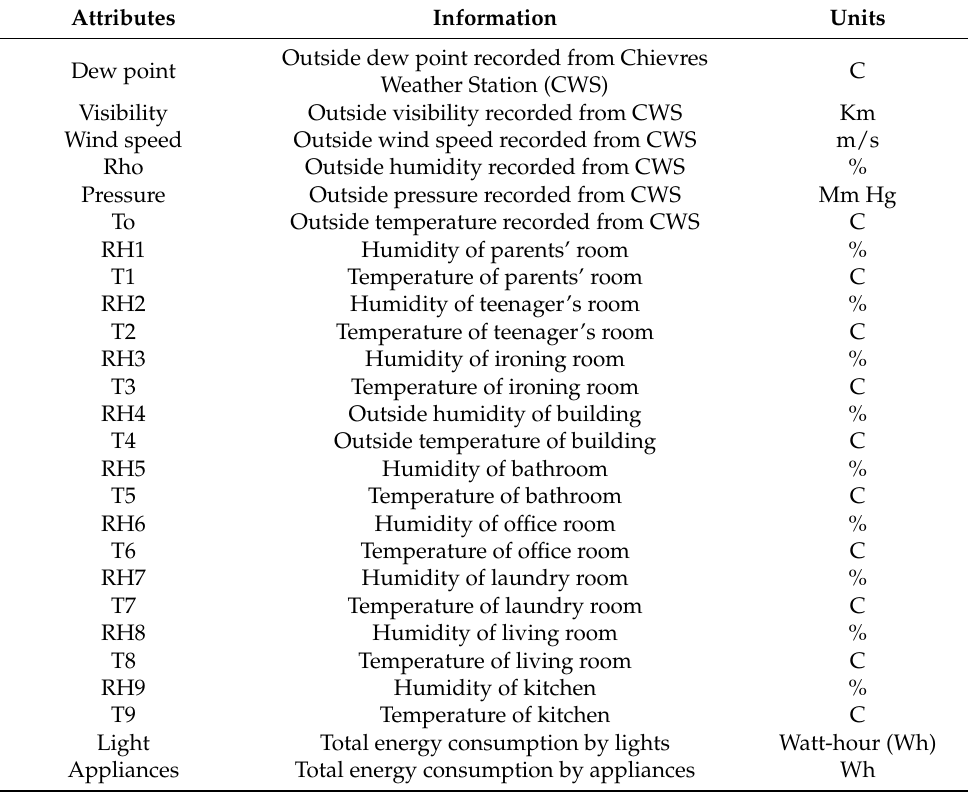
Table 1. Statistical information about the AEP dataset.